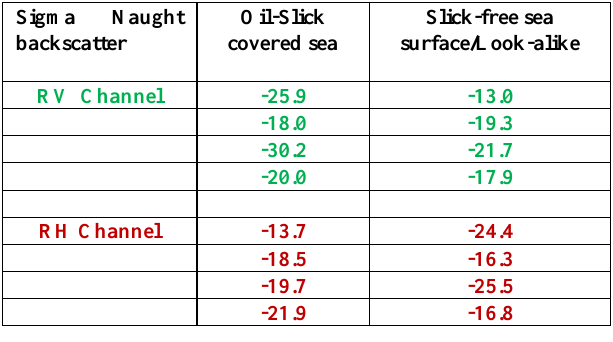
Table 1: Sigma Naught Backscatter values for RH and RV